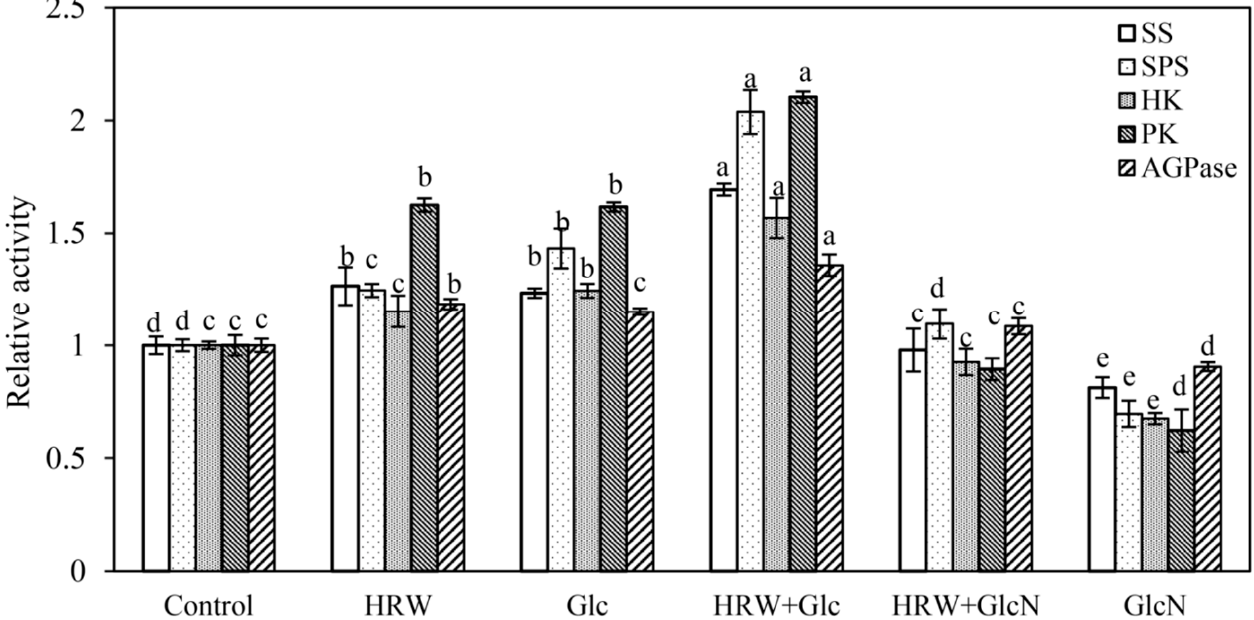
Figure 4. Effects of HRW, Glc and GlcN on SS, SPS, HK, PK and AGPase enzyme activities of cucumber explants. n = 30 explants per replicate. Bars with different lower case letters were significantly different ( p < 0.5). HRW: hydrogen rich water; Glc: glucose; GlcN: glucosamine; SS: sucrose synthase; SPS: sucrose phosphate synthase; HK: hexokinase; PK: pyruvate